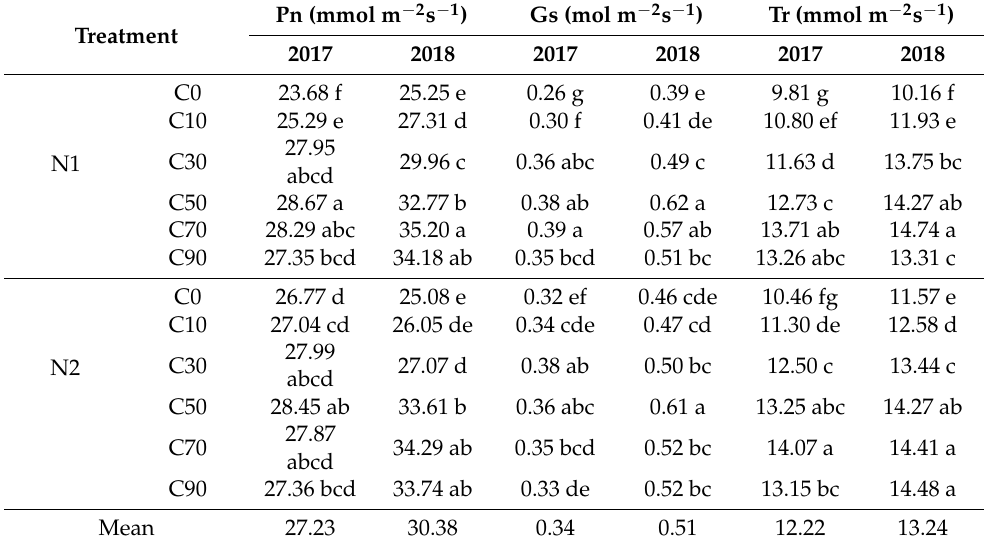
Table 2. The effects of biochar on gas exchange parameters in tomato leaves under low (N1) and normal (N2) nitrogen fertilization in 2017 and 2018. Different lowercase letters denote significant differences among treatment means at the 0.05 level by Duncan’s MRT